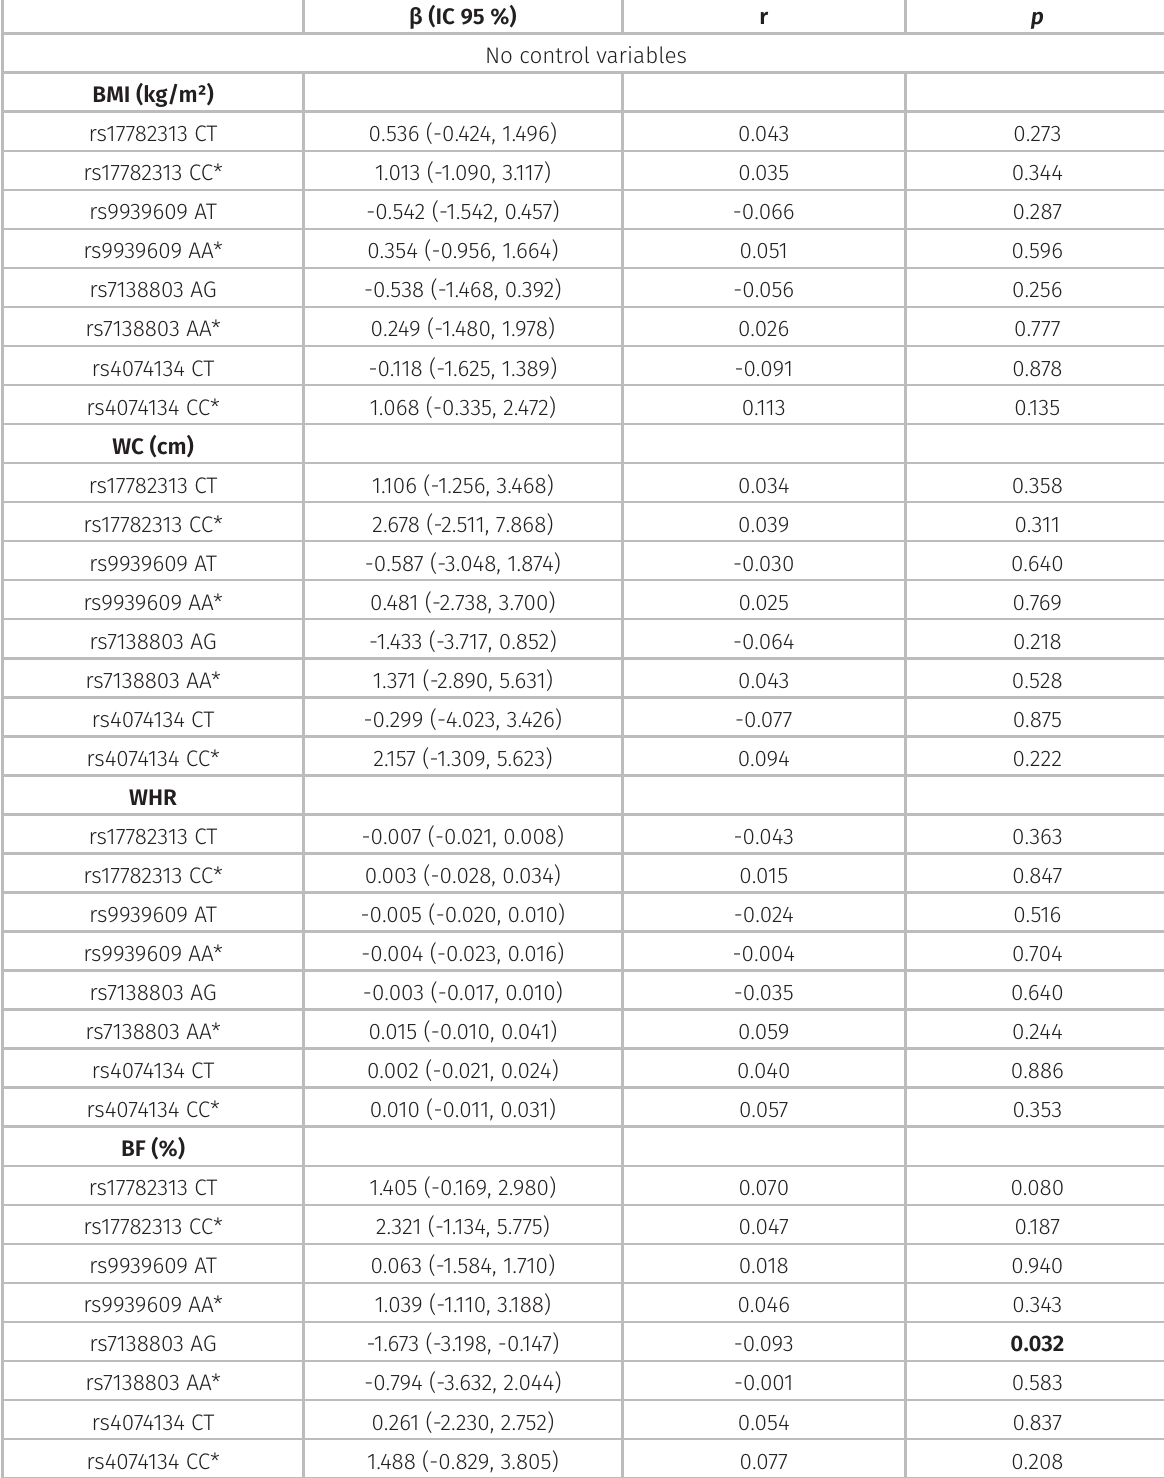
Table IV. Multiple linear regression association and correlation analyses results, as well as confidence intervals and p -values, between the SNP genotypes and the obesity-related